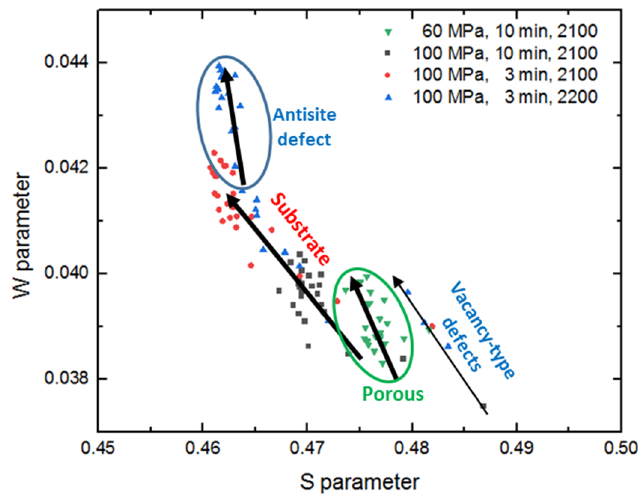
Figure 5. Dependence of line-shape S-parameters of the DB spectra on W-parameters. From the W–S curve, the annihilation traces of positrons in the samples can be seen. It was observed that positrons are annihilated in the substrates for most specimens. However, for the specimen prepared at 60 MPa, the positrons are mainly annihilated in the pores due to the larger size of the pores (green circle). Compared to the specimen fabricated in 10 min at 100 MPa, the pore size is smaller due to the higher sintering pressure, and the W–S curve is closer to the substrate